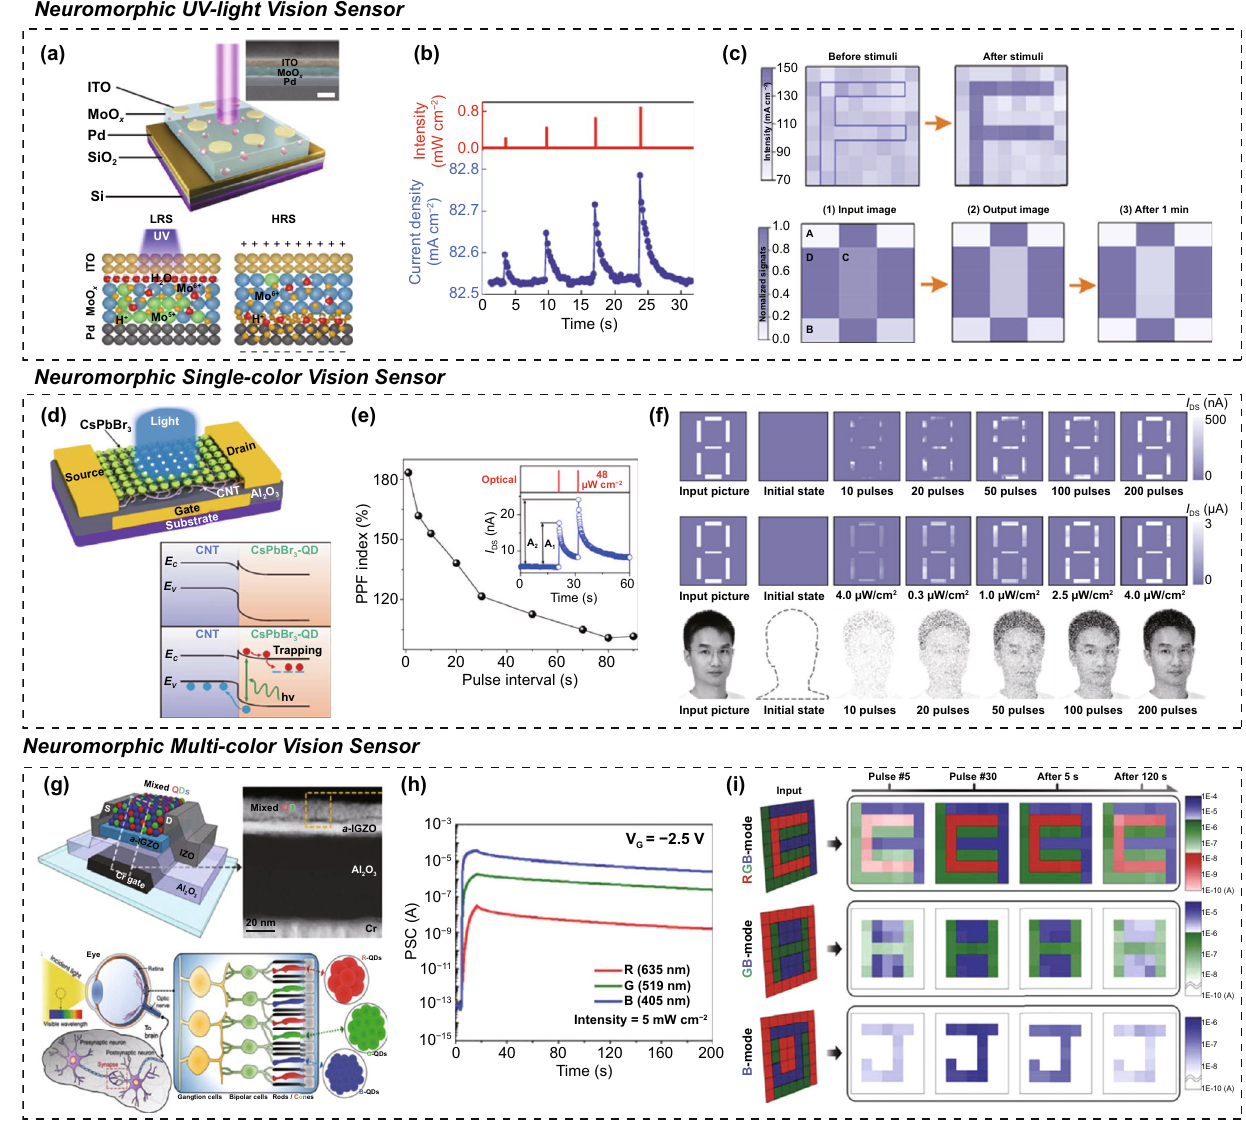
Fig. 7 OSs for in‑sensor computing system; device configuration; and neuromorphic vision perception. a – c Neuromorphic UV‑light vison sen‑ sor; a device schematic of memristor‑type OS, b light‑driven conductance switching behaviors, and c imaging and pre‑processing of UV‑light pattern images. d – f Neuromorphic single‑color vison sensor: d device schematic of transistor‑type OS, e light‑driven conductance switching behaviors, and f imaging and pre‑processing of single color pattern images. g – i Neuromorphic multicolor vison sensor: g device schematic of the transistor‑type OS, h color‑driven conductance switching behaviors, and i imaging and pre‑processing of mixed color patterns. a – c Repro‑ duced with permission from Ref. [54]. Copyright @ 2019, Springer Nature. d – f Reproduced with permission from Ref. [55]. Copyright @ 2021, Springer Nature. g – i Reproduced with permission from Ref. [56]. Copyright @ 2022,